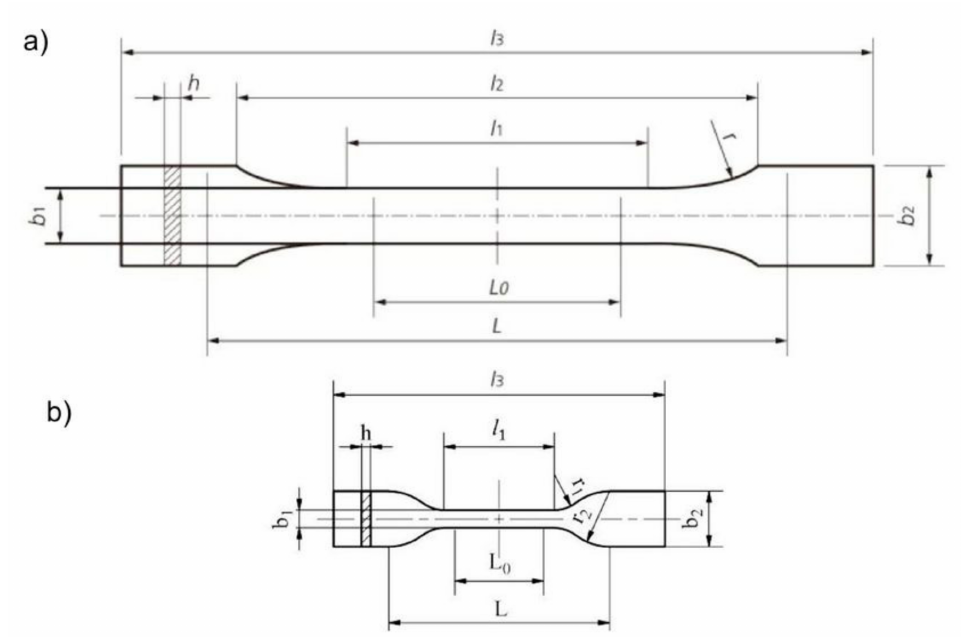
Figure 1. Universal dog bone samples used for tensile strength tests: ( a ) type A1, ( b ) type